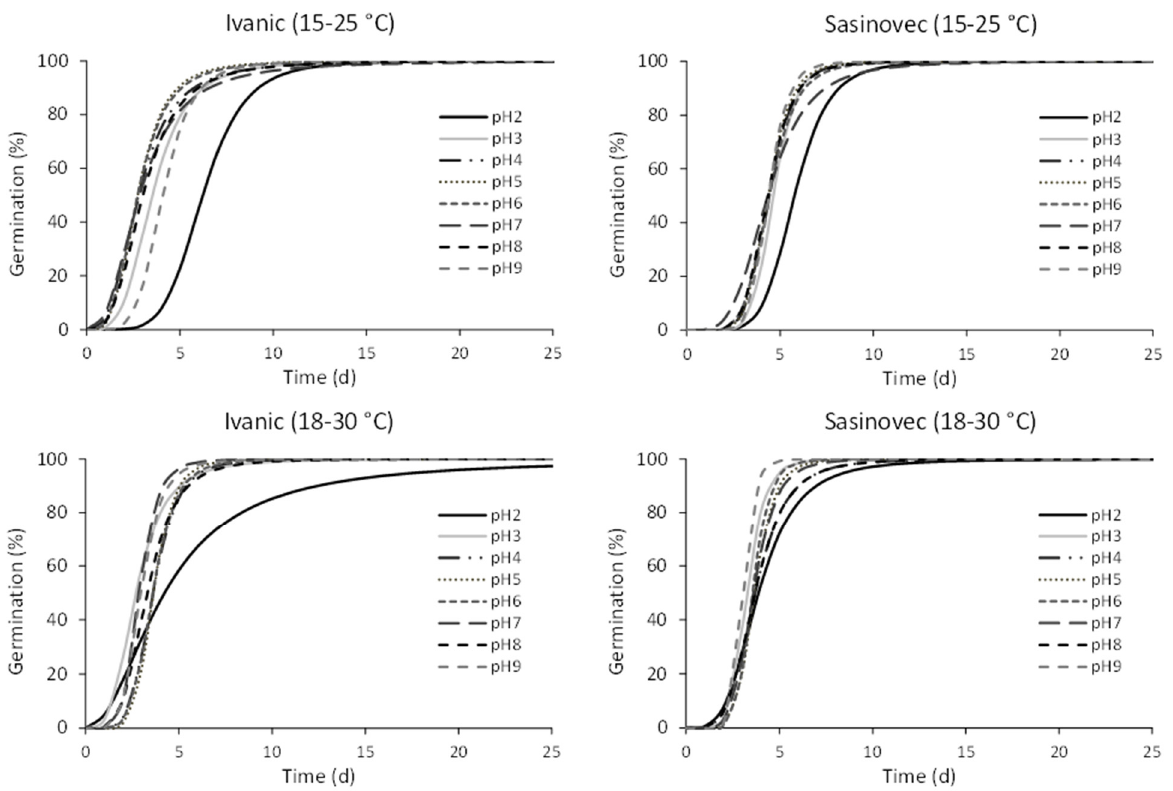
Figure 6. Germination patterns of the two populations of D. stramonium in different temperature ranges and pH levels. The parameters estimated and the measures of goodness of fit are given in the Appendix A (Table A2).